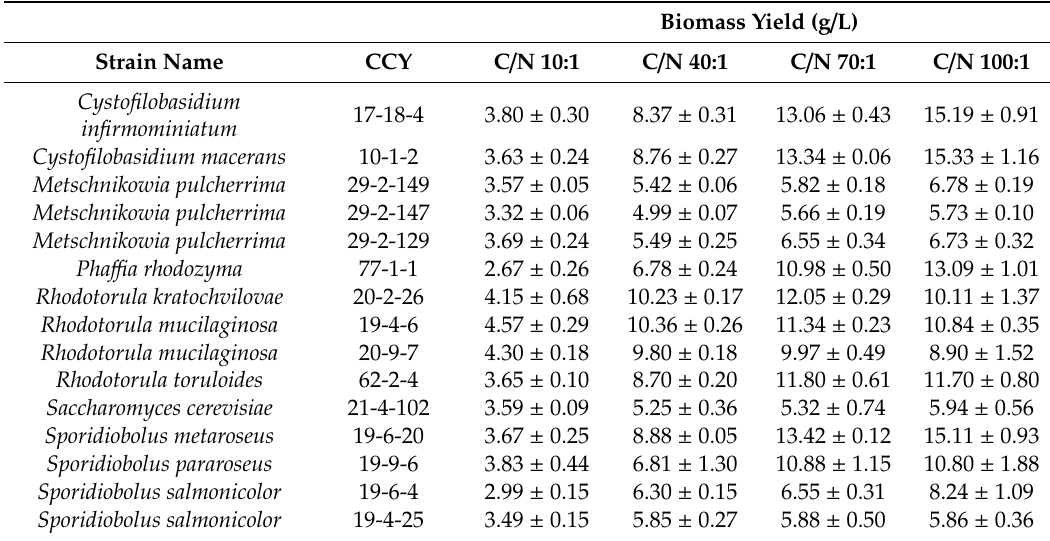
Table 2. Biomass yield for yeast grown in the media with low and high C / N ratios.